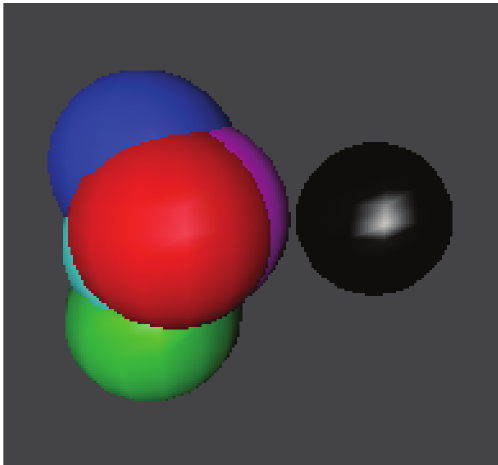
Figure 6: Results of bootstrapped PCA examining di ff erences between ethogram data and di ff erent visitor segments. Black = ethogram data for group of otters, red = fun time families, green = sensualists, dark blue = social naturalists, light blue = expert birders, and pink = learn together families. No other visitor segments were included, since in total they contained < 20 responses. Pairwise comparisons between social naturalists and sensualists also indi- cated no significant di ff erences occurred between these categories. Cumulative proportion of variance explained by first 3 principal components =